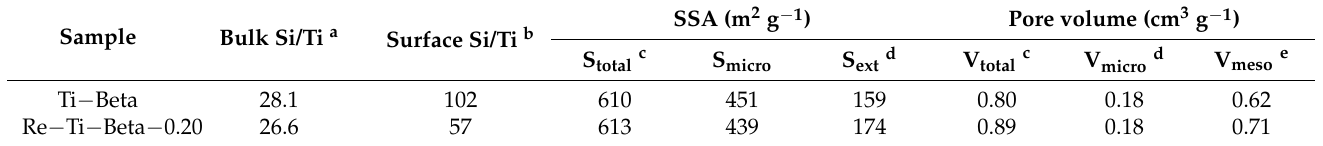
Figure 5. N 2 adsorption − desorption isotherms at 77 K of Ti − Beta (a) and Re − Ti − Beta − 0.20 (b). Table 1. Textural properties of Ti − Beta and Re − Ti − Beta − 0.20. Table 1. Textural properties of Ti − Beta and Re − Ti − Beta − 0.20.